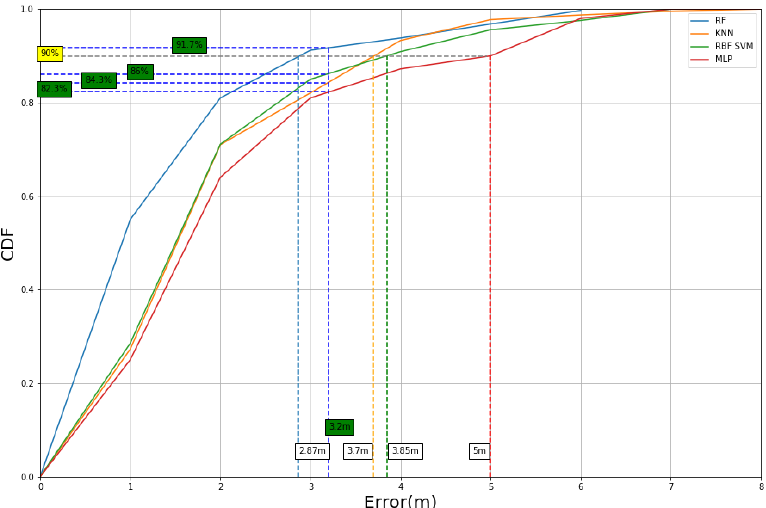
Figure 12. Cumulative distribution function of the position error in